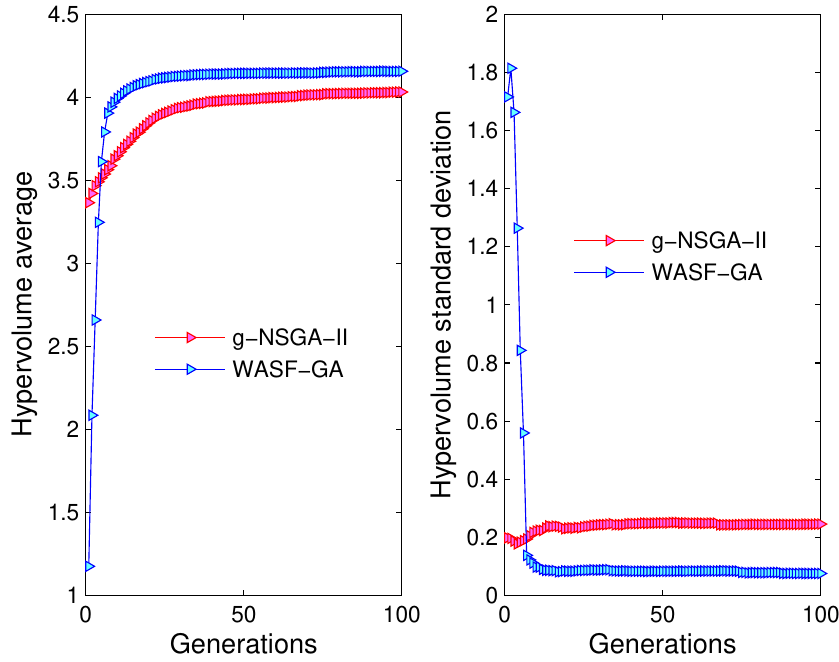
Figure 12. Evolution of the average hypervolume ( left ); and evolution of the standard deviation hypervolume ( right ) for g-NSGA-II, WASF-GA, DM’s partial-preferences ( 15,0.0025 ) ( N =